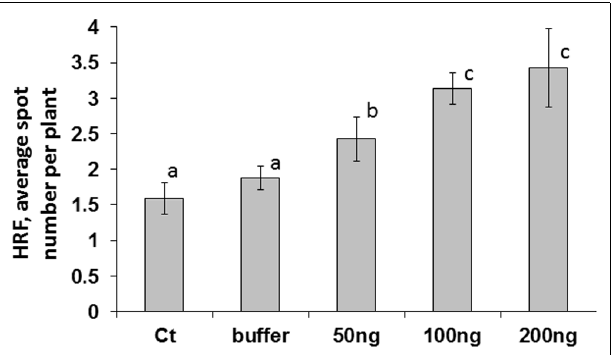
FIGURE 2 | Detecting coat protein mRNA. Plants were infected with 100 ng of ORMV, both infected and non-infected leaves were taken for the analysis at different time points (from 0 to 5 days). Four independent plants were used per each experimental time point. mRNA was isolated, converted to cDNA and used to amplify coat protein RNA via qRT-PCR. ORMV was converted to cDNA and used as a negative control in the amplification (no amplification was found in this sample). Negative control sample contained no gDNA/cDNA. Y axis shows arbitrary units of cDNA amplified using primers against gene coding for coat protein. X axis shows time in hours after infection. Data are shown in arbitrary units (with SD). Asterisks show significant difference from negative control ( P <